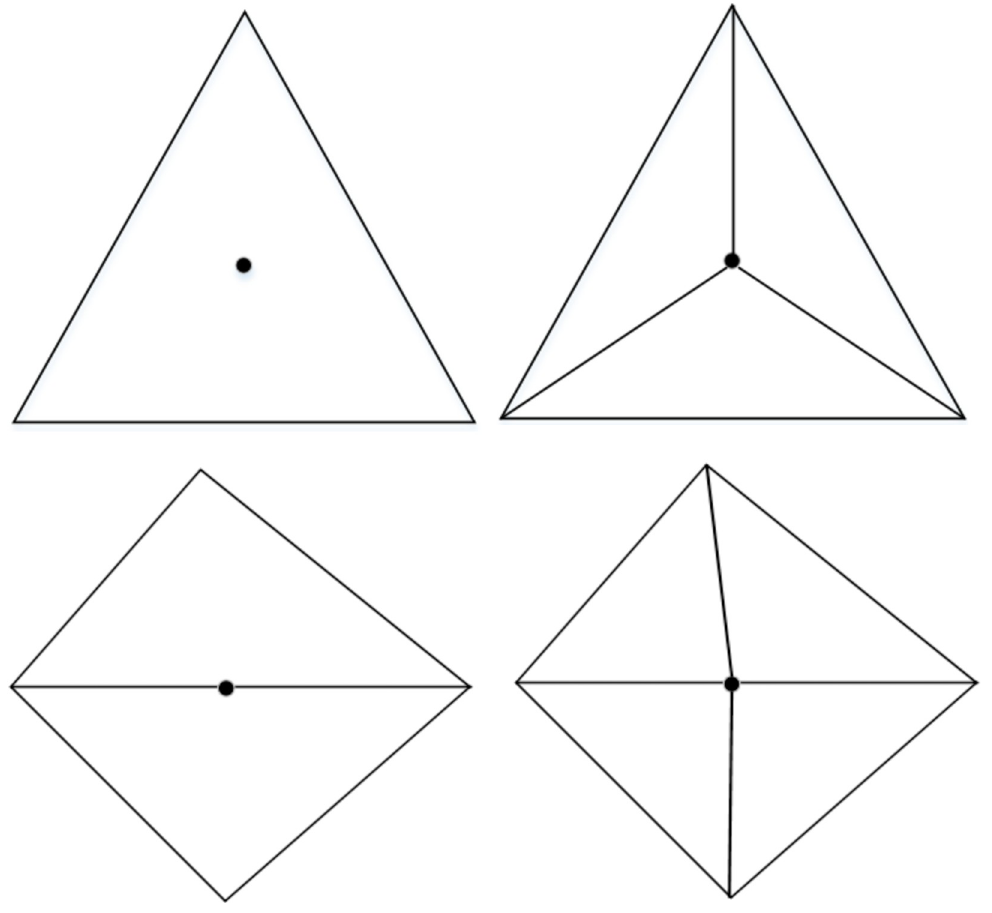
Fig 9. Local modification of the